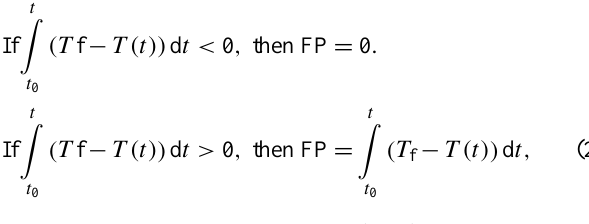
Figure 5. Definition of the three types of period within a freeze– thaw